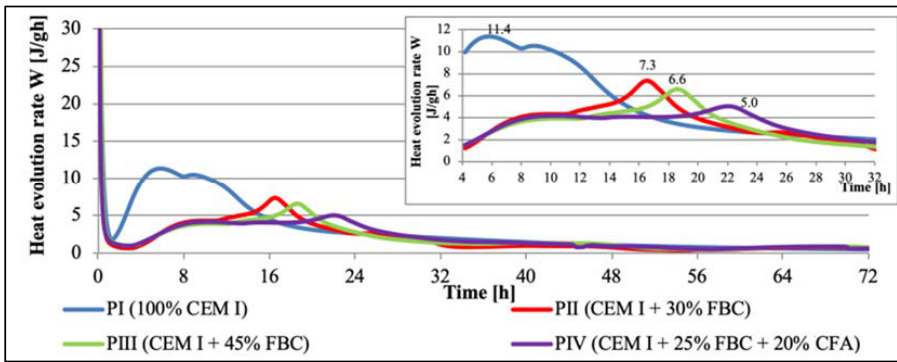
Table 7. The maximum reaction rate of C 3 S.